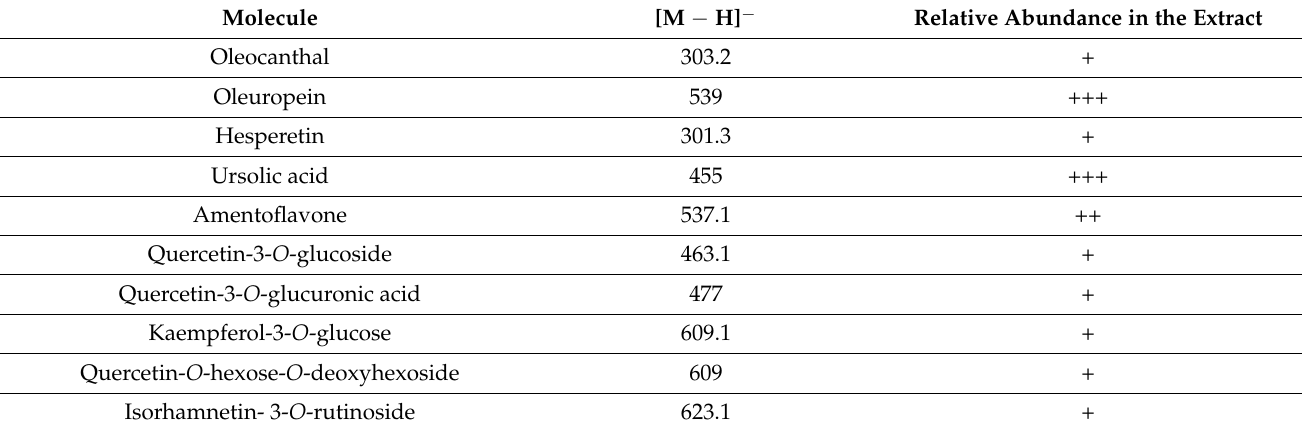
Table 1. Summary of the identified molecules and their abundance estimation in the extract.